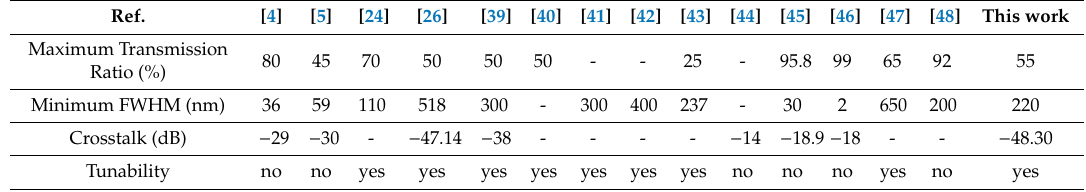
Table 4. Comparison of maximum transmission ratios of this work with some others